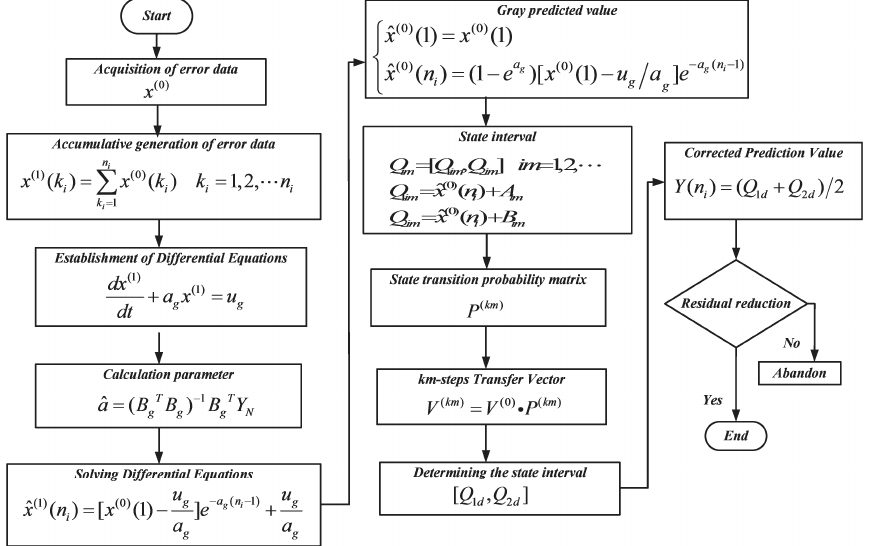
Figure A1. Flow chart of Grey–Markov method error prediction.